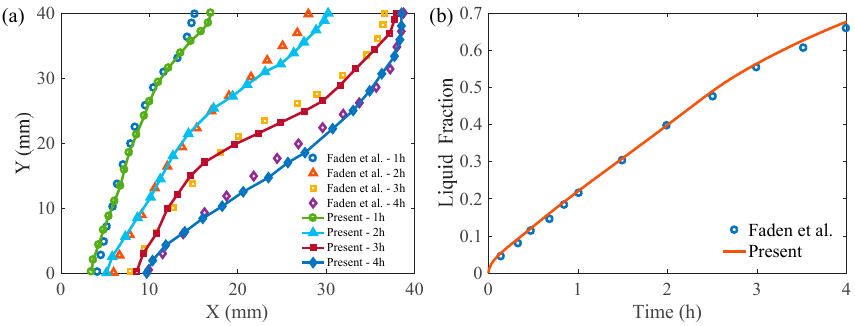
Figure 5. Validation of the present numerical model with the experimental data reported by Faden et al. [36]. ( a ) Melting front; ( b ) liquid fraction.